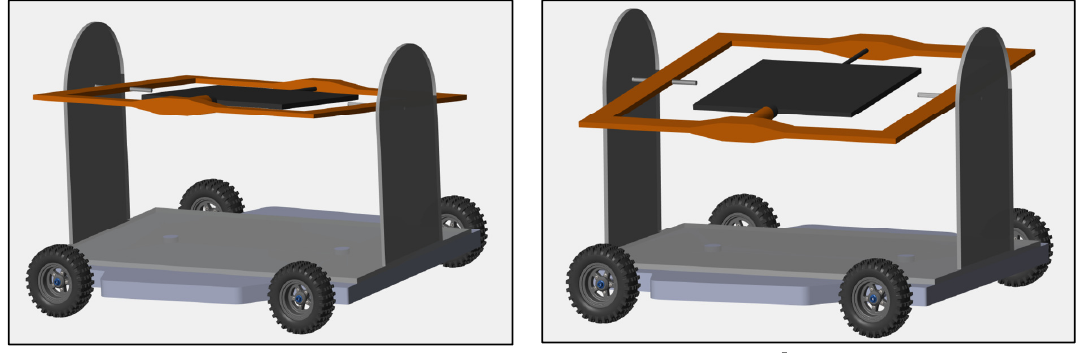
a b Fig. 11. Self-balancing of the (platform on the mobile car a) structure in the virtual simulation a) under tilt angle 10° on positive X-axis b) under tilt angle -10° on negative X-axis. positive Y-axis and -10° on negative Y-axis) is shown in figure 12. The self-balancing of the (platform on the mobile car) structure in the virtual simulation environment under tilt angle 10° on positive Y-axis and -10° on negative Y- axis is shown in figure 13: (a, b).